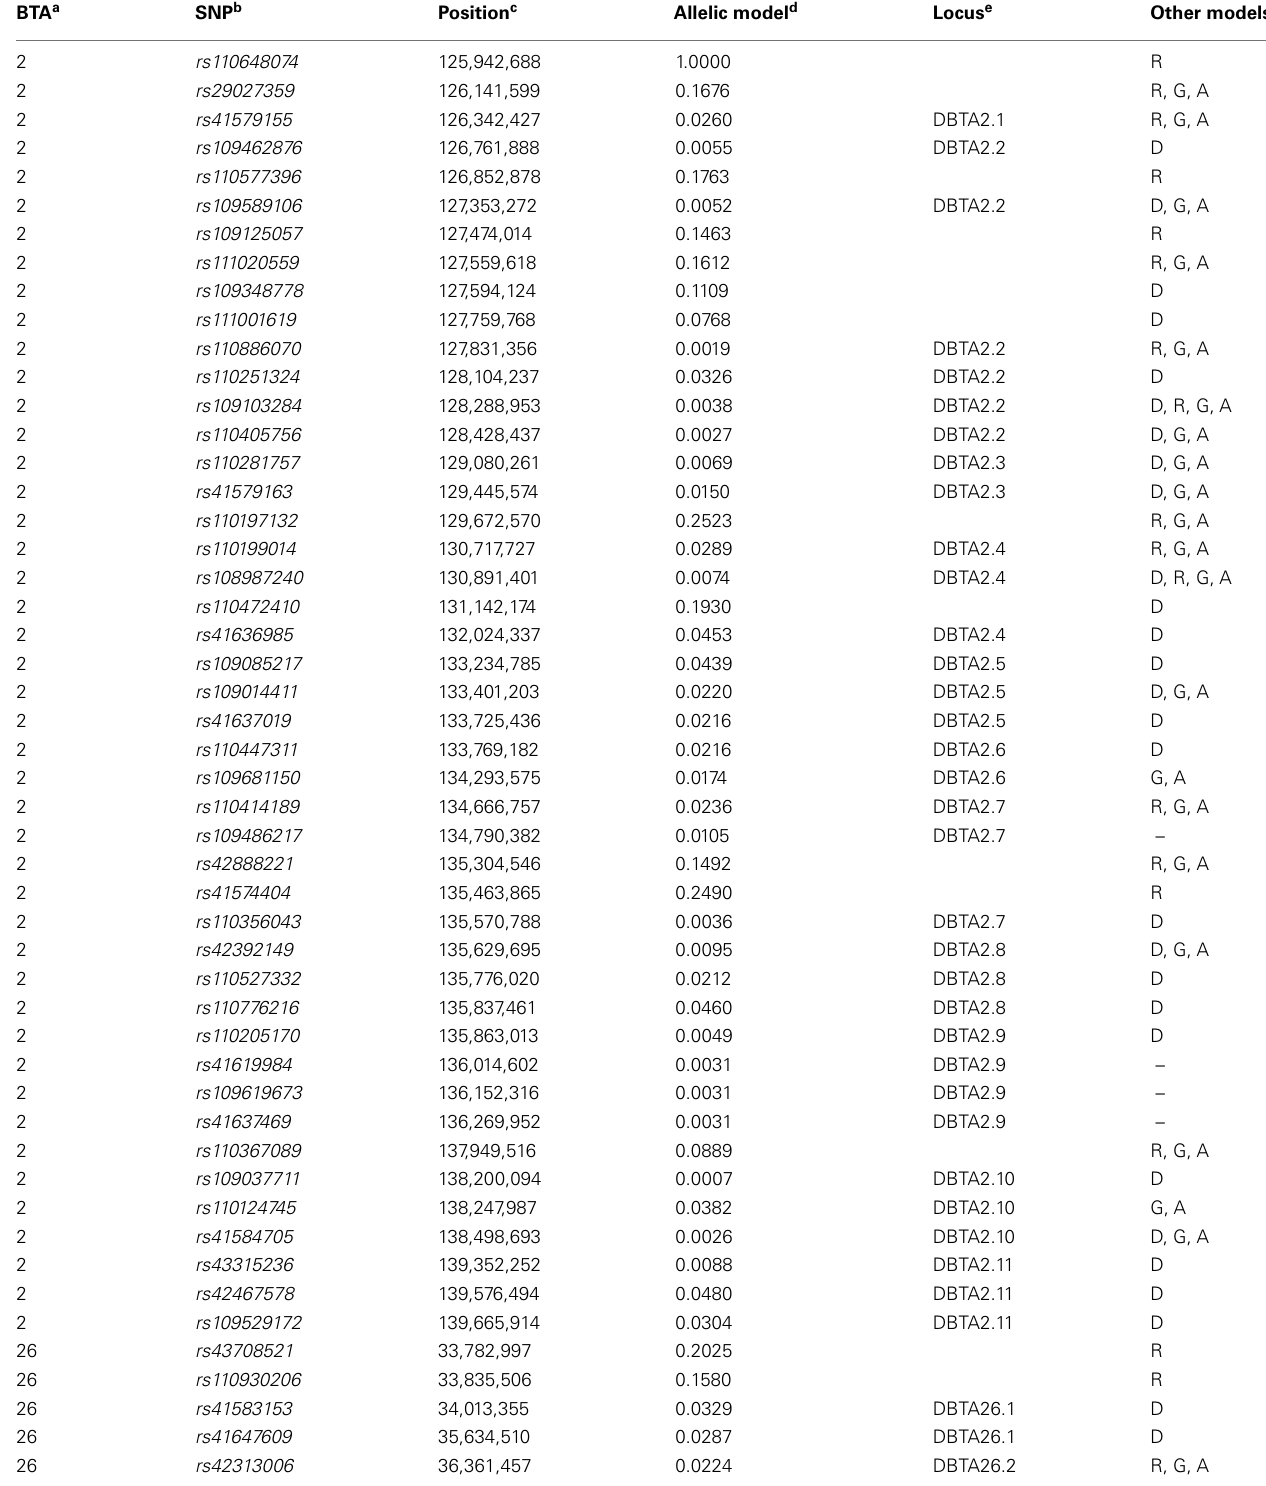
TableA1 | Single nucleotide polymorphisms that represent loci associated with dams of bovine viral diarrhea persistently infected calves on BTA2 and